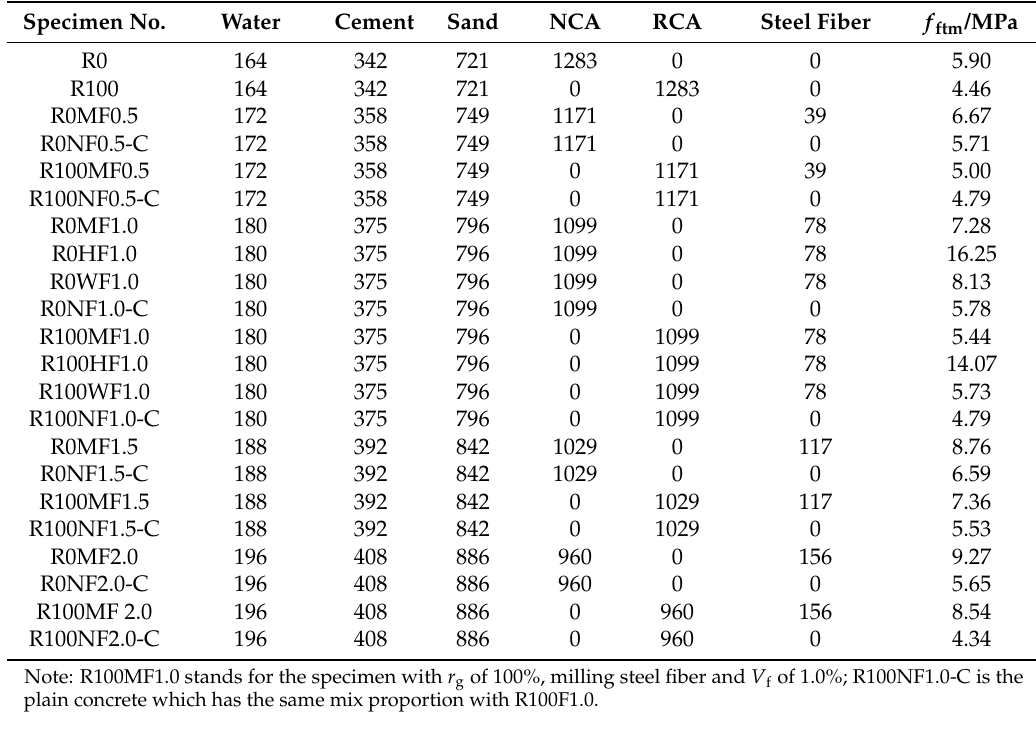
Table 4. Mixture design (kg/m 3 ) and flexural strength of steel fiber reinforced recycled coarse aggregate concrete (SFRCAC) with different steel